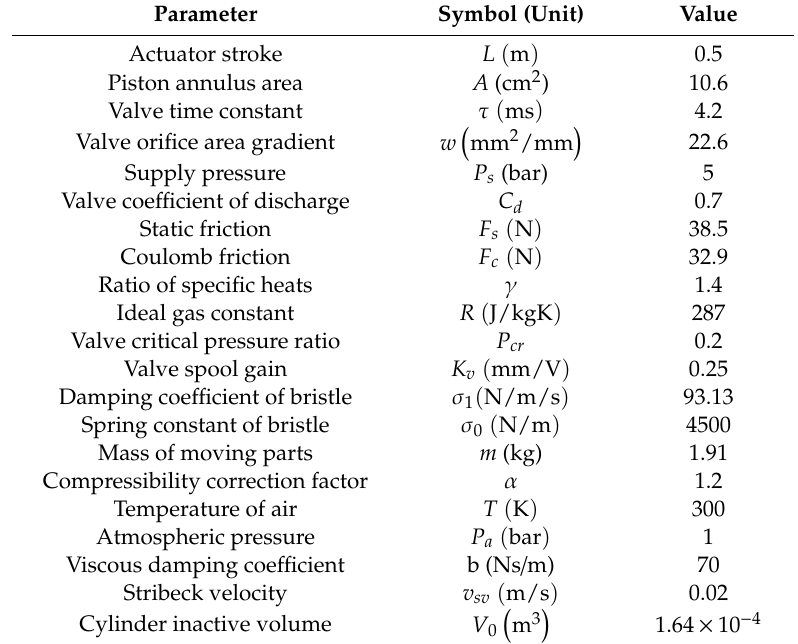
Table 1. Parameters of Pneumatic Actuator [26].